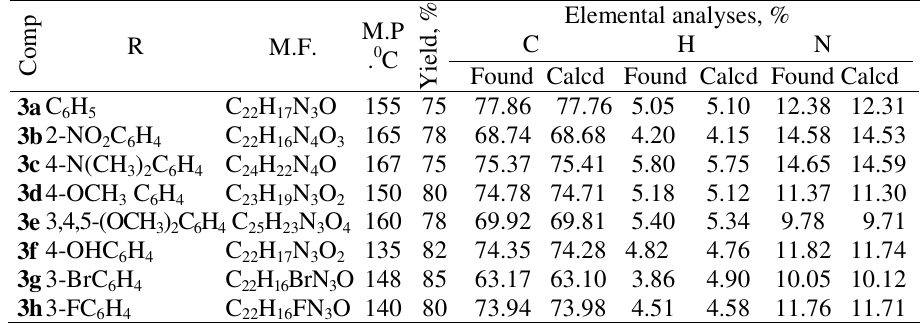
Table 1. Physical data of compounds 3a-h.